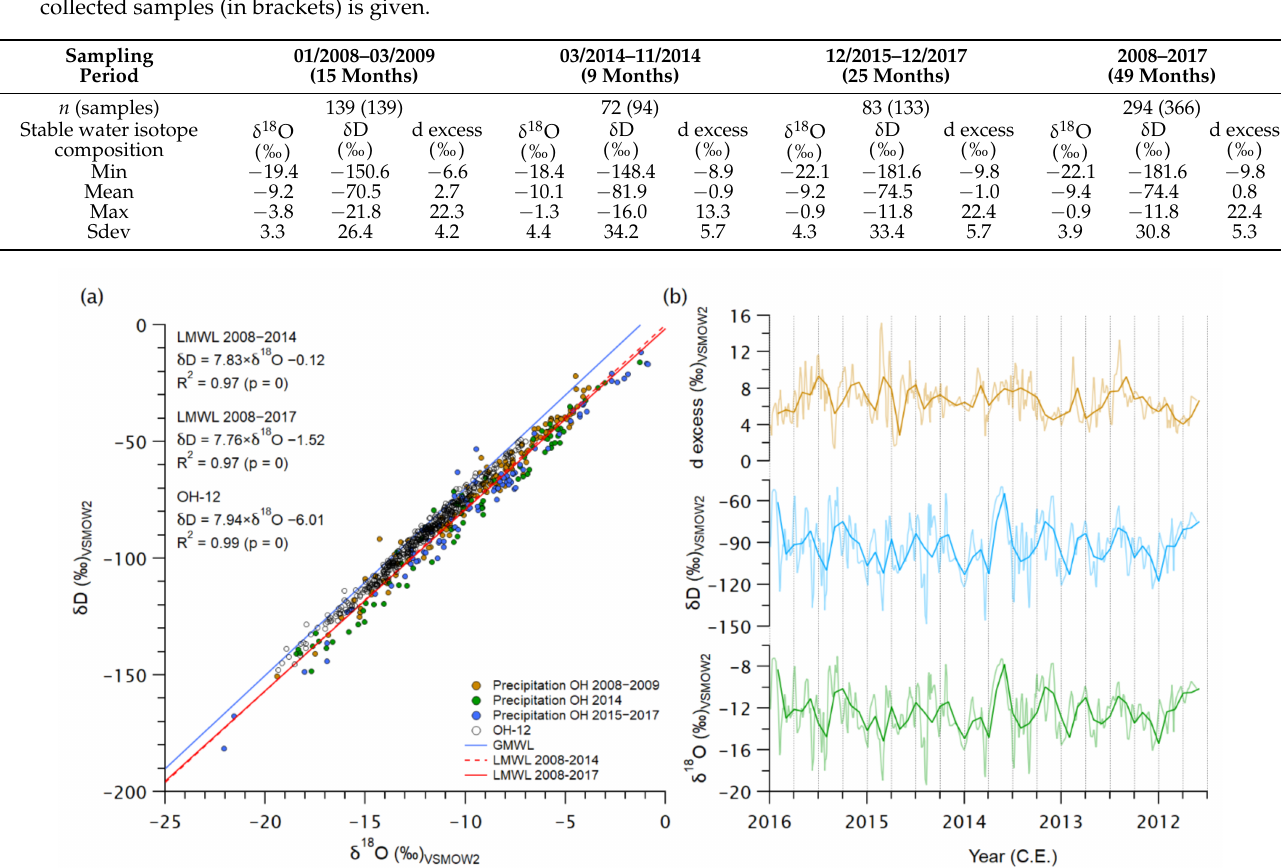
Figure 6. ( a ) δ 18 O– δ D relationship of all considered precipitation samples collected at Bernardo O’Higgins station (OH) between 2008 and 2017 ( n = 294; coloured dots) compared to the δ 18 O– δ D relationship of firn core OH-12 ( n = 414; white dots). The Global Meteoric Water Line (GMWL) is indicated in blue. The Local Meteoric Water Line (LMWL) established for the study site by Fernandoy et al. [31,32] is shown as a dashed red line and the LMWL derived in this study as a solid red line. For each δ 18 O– δ D relationship, the equation, the coefficient of determination (R 2 ) and the p -value ( p ) are given. ( b ) Time series of δ 18 O, δ D and d excess of OH-12 constructed based on the weighted age scale. High-resolution data are shown as light-coloured lines and monthly means as bold